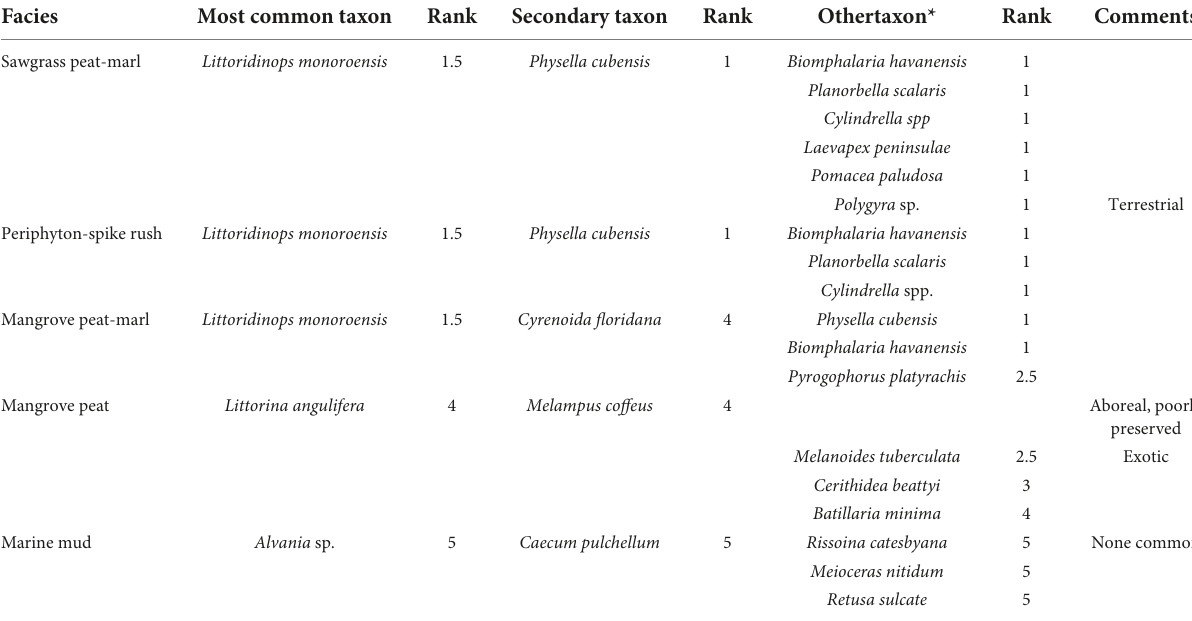
TABLE 2 Mollusk taxa found in each